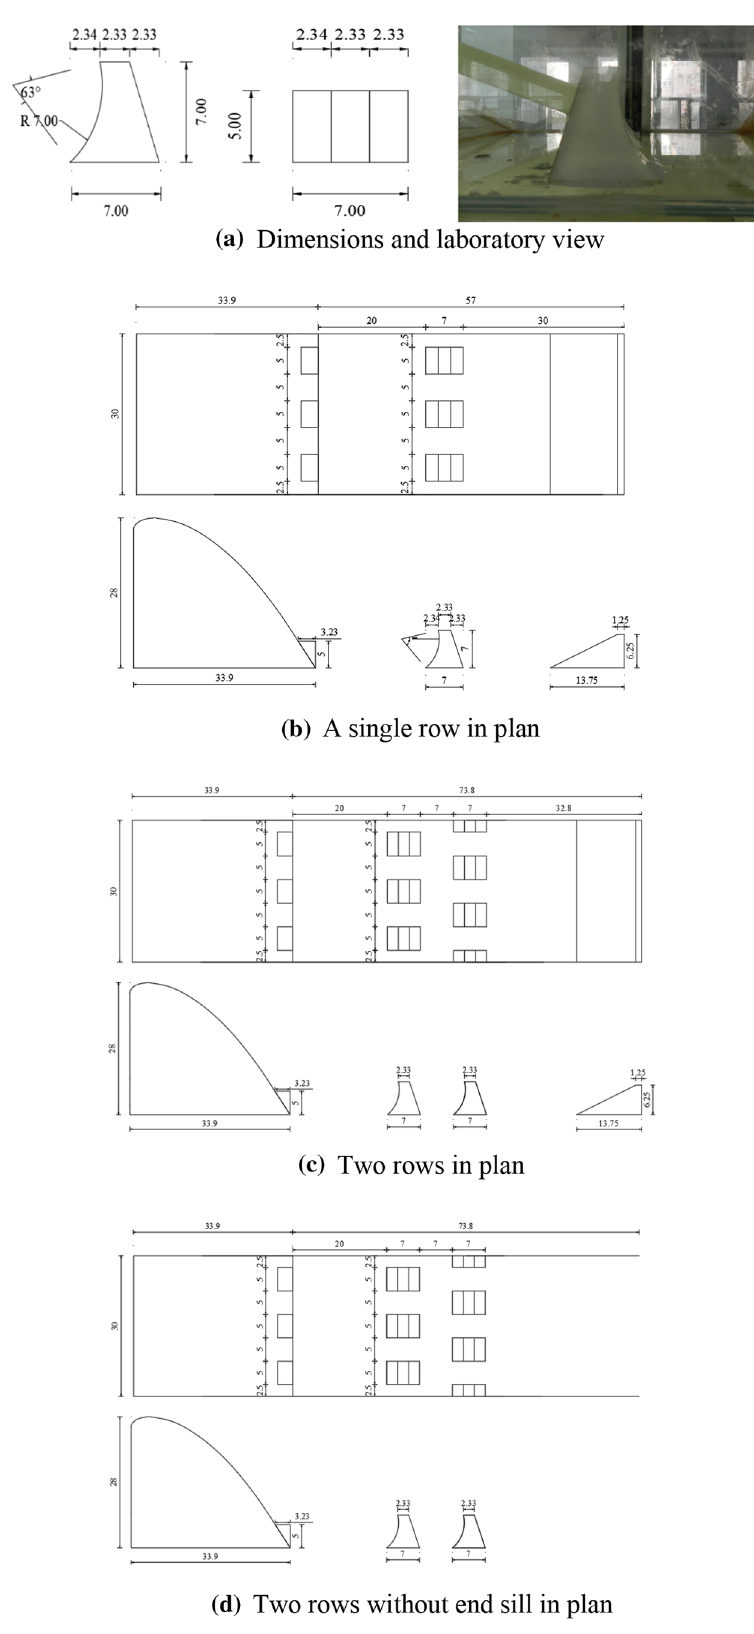
in the experiments. a Dimen- sions and laboratory view. b A single row in plan. c Two rows in plan. d Two rows without end sill in